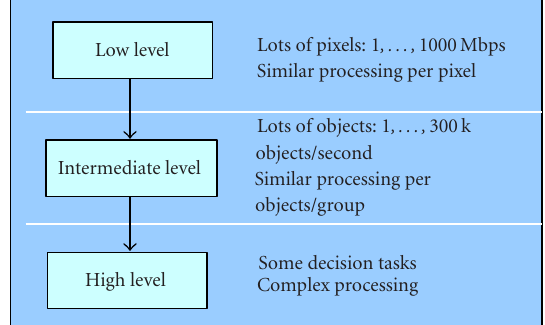
Figure 2: Data entities with processing characteristics and possible ways to increase performance by exploiting